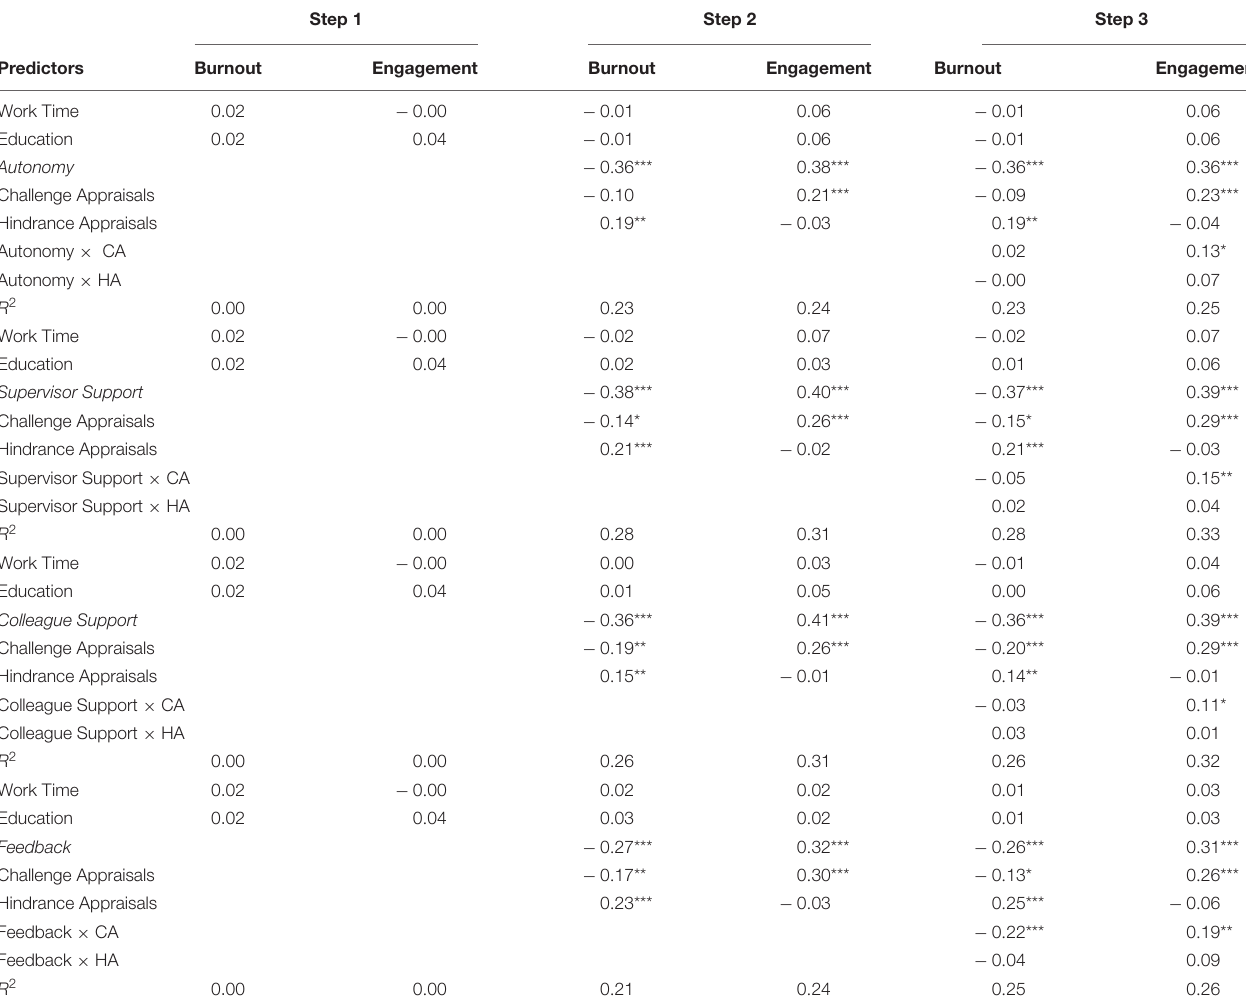
TABLE 8 | Regression results for the moderation of appraisals on the relationships between job resources and work engagement/burnout in Study 2. Step 1 Step 2 Step